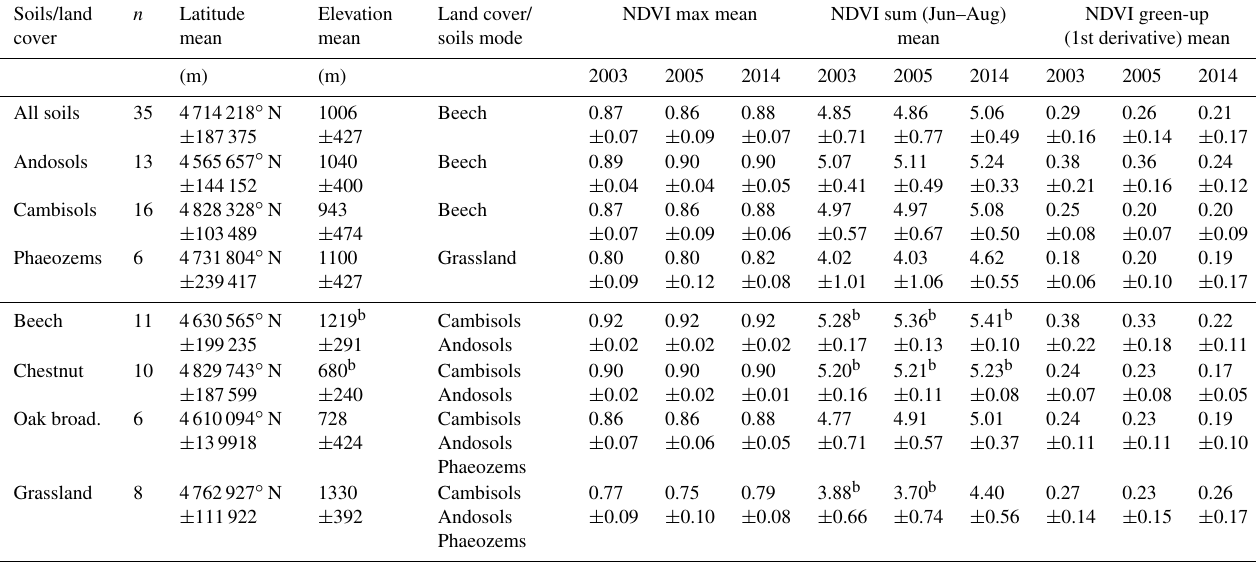
Table 1. Main geographical, land cover, soil and NDVI features of the studied soils. Soils/land